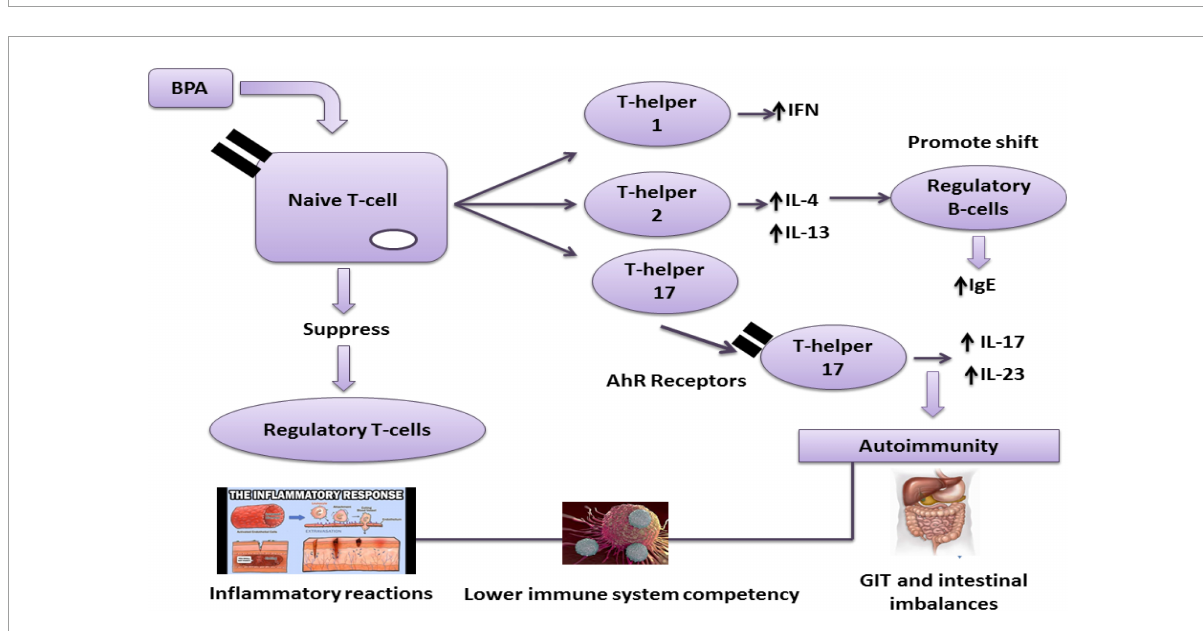
FIGURE5 Effect of the BPA immune system BPA can promote autoimmunity via T-helpers 1, 2, and 17. Aryl hydrocarbon receptors (AhR) are involved in regulating immune responses, followed by the production of T-helper 17 a critical factor in T-cells in various autoimmune